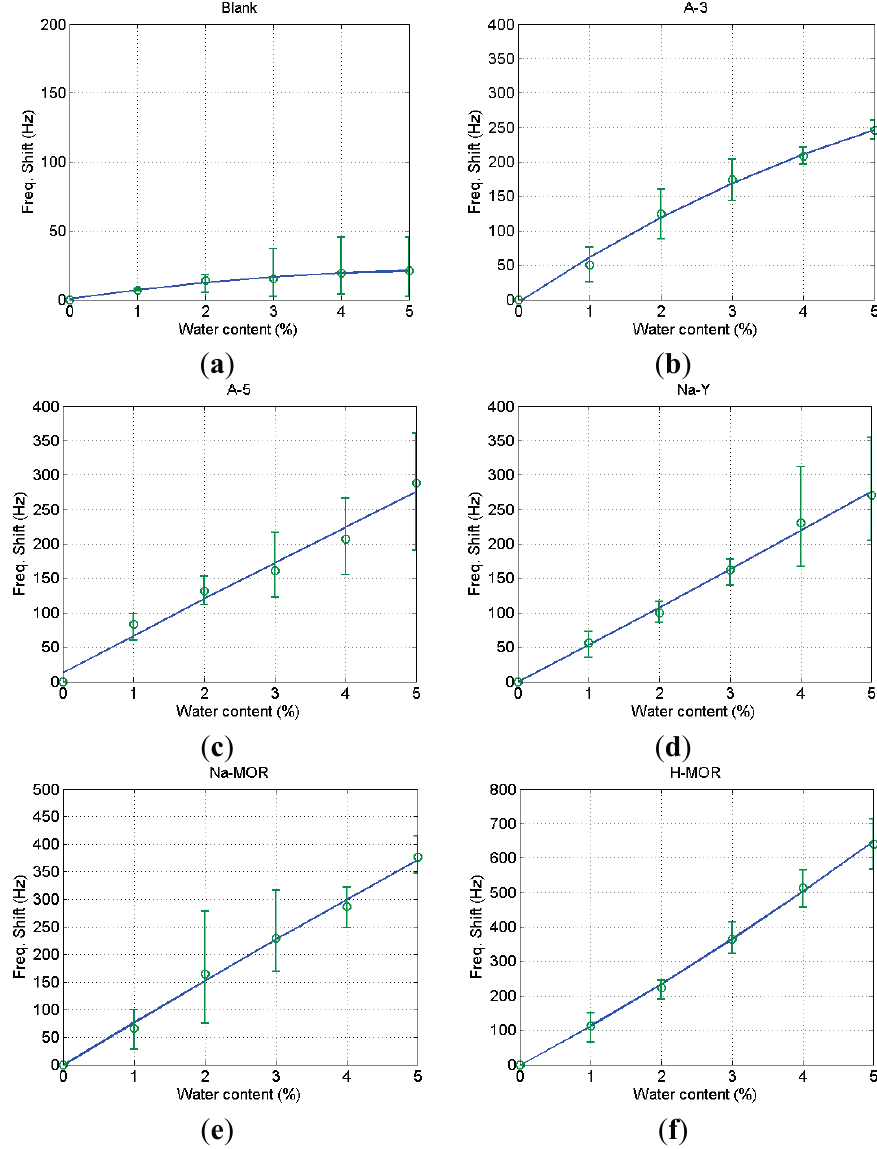
Figure 4. Frequency shifts of blank QCM ( a ) A-3 coated QCM; ( b ) A-5 coated QCM; ( c ) Na-Y coated QCM; ( d ) Na-MOR coated QCM; ( e ) H-MOR coated QCM; ( f ) At different water contents.